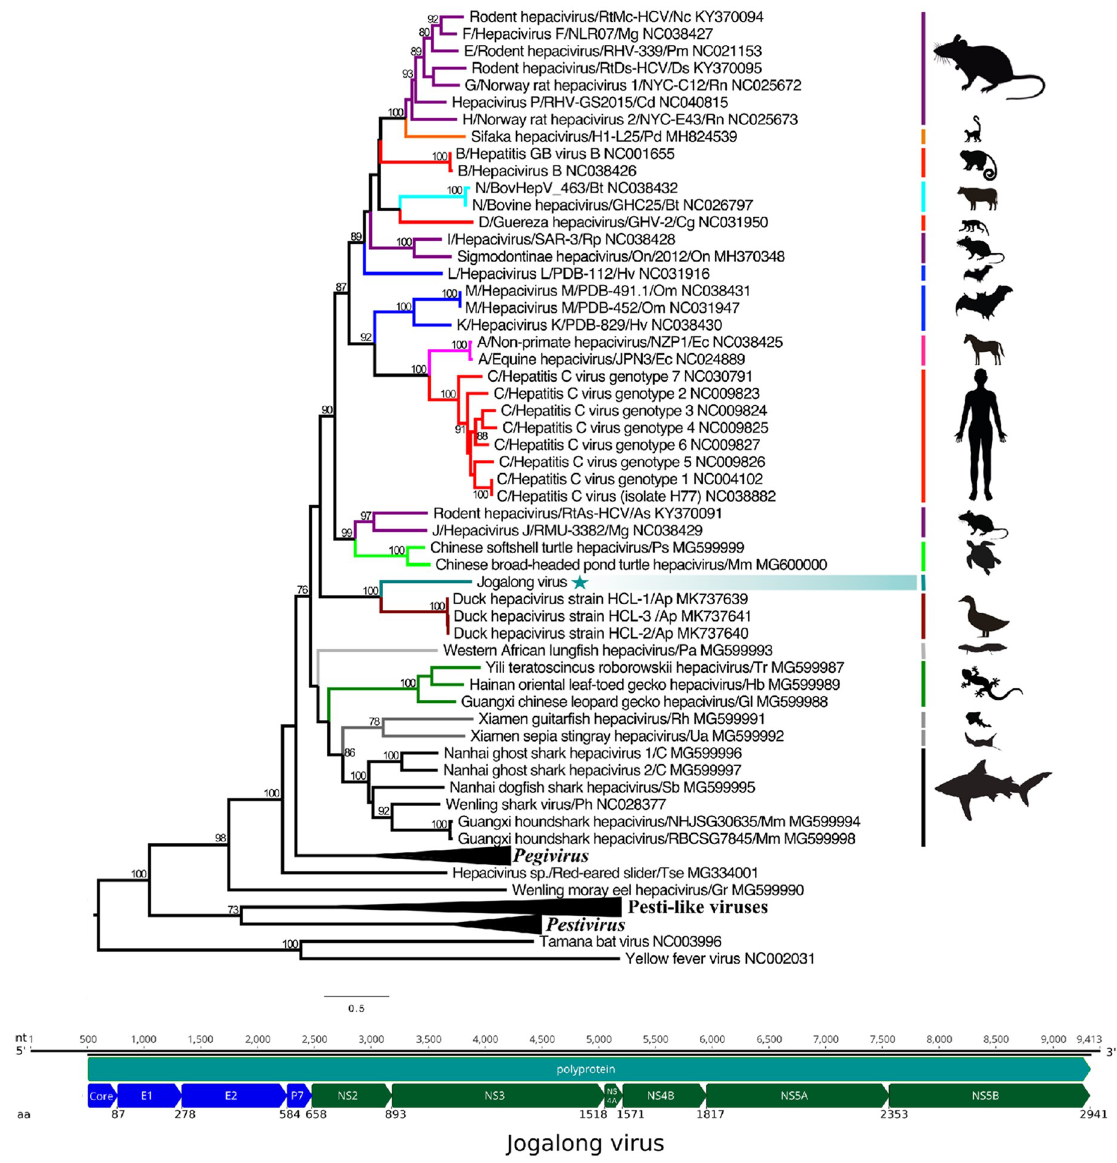
Fig 2. Phylogenetic analysis and putative genome organization of Jogalong virus. The maximum likelihood tree was constructed using a conserved region within the NS5B protein. The scale bar represents substitutions per site and bootstrap values are displayed when greater than 70%. The genera Pestivirus , Pegivirus , and recently discovered Pesti-like viruses are indicated with a black triangle. Jogalong virus is indicated with a teal star. Hepaciviruses and their associated hosts are indicated by vertical bars. The putative location of the polyprotein (teal arrow) and cleaved structural proteins (blue arrows) and non-structural proteins (dark green arrows) are indicated in the genome map located beneath the tree. Nucleotide (nt) and amino acid (aa) positions can be found above and below the illustration,